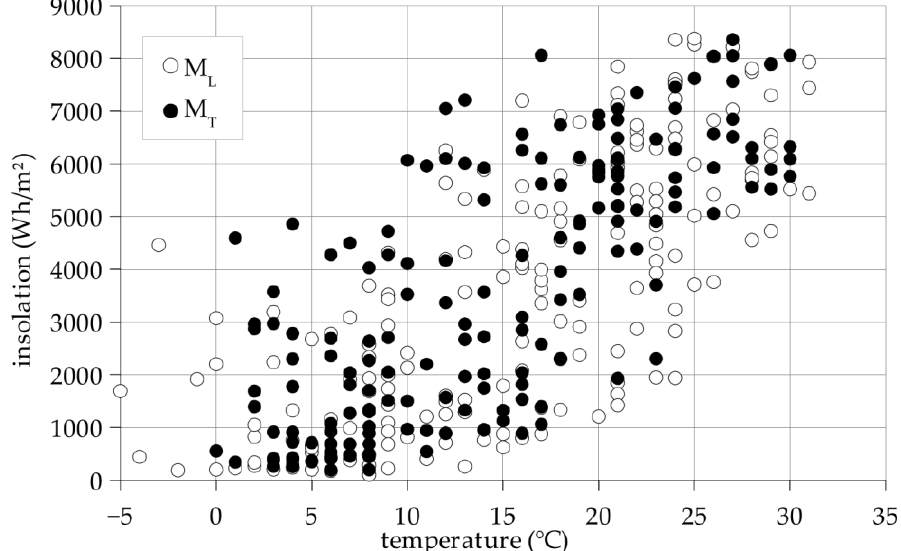
Figure 2. Distribution of measurement points in the temperature set T. Figure 3. Distribution of measurement points for the set of insolation G.